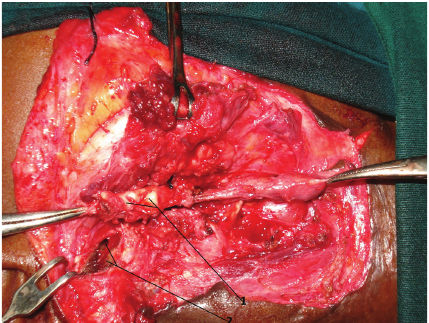
Figure 6: Perioperative photographs after resection of aural end of the fistula. The upper part of the fistula is thick containing cartilage representing the duplication of cartilaginous part of external audi- tory canal (marked as 1). The defect in external auditory canal is marked as 2.